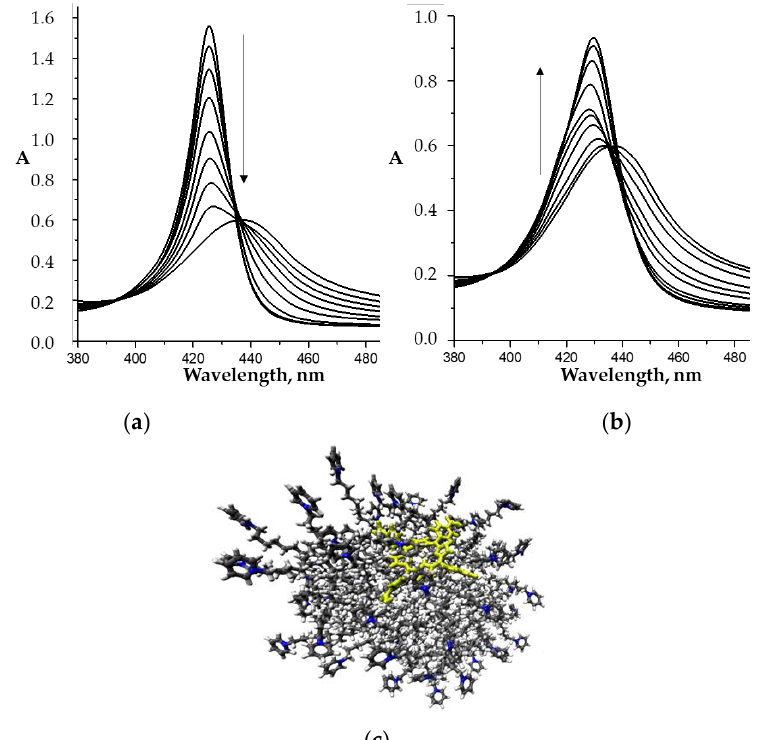
Figure 7. UV–Vis spectra (Soret band region) of the Co(III)P(1-2)-(L1) 2 in phosphate buffer (pH 7.4) 25 ◦ C upon titration with CPC: ( a ) − C CPC = 0 ÷ 2 × 10 –5 M; ( b ) − C CPC = 2 × 10 -5 ÷ 4 × 10 –4 M); and ( c ) schematic image of the micelle structure [Co(III)P(1-2)-(L (cid:48) )(L (cid:48)(cid:48) )] CPC .